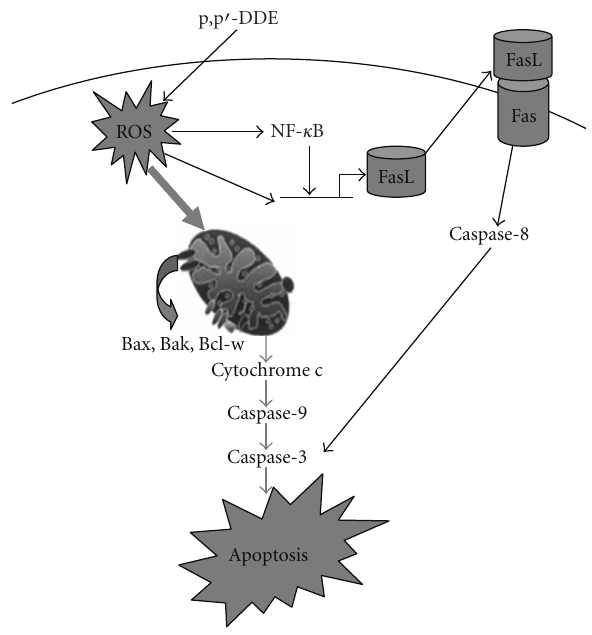
Figure 7: Proposed model of p,p (cid:2) -DDE-induced signaling pathways leading to apoptosis. ROS generation might play a critical role in the initiation of p,p (cid:2) -DDE-induced apoptosis of Sertoli cells through two mechanisms, one was the mitochondria-mediated pathway including elevation of ROS, decrease in ΔΨ m along with the cytochrome c release from mitochondria into the cytosol, and activation of the caspase-9 and -3 in our previous study; and the other was the elevation of ROS, which resulted in activation of NF- κ B, expression of FasL and triggered FasL-dependent pathway (FasL/caspase-8/-3 signaling module) in our present